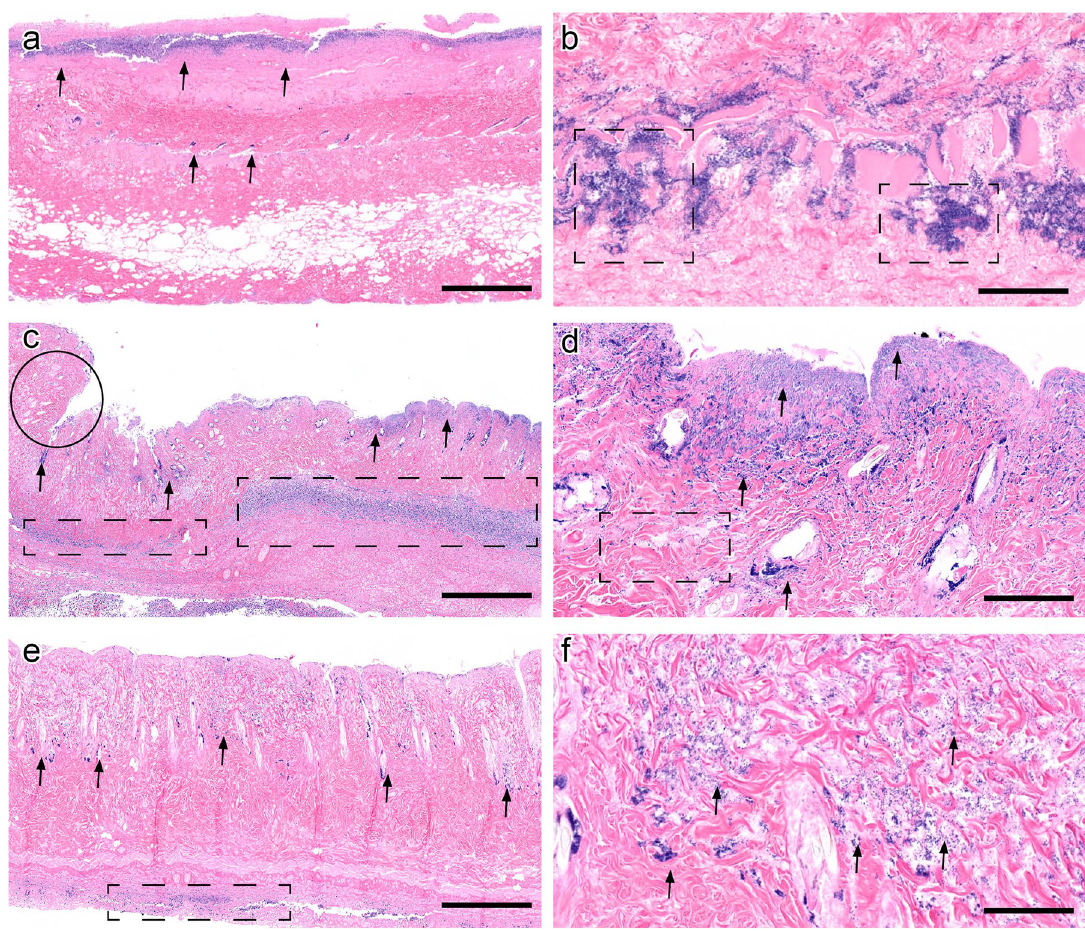
Fig 3. Histological evaluation of infected pressure ulcers in diabetic TALLYHO/JngJ mice. (a) Negative controls (vehicle alone) were characterized by dense thick carpets of superficial bacterial colonies (arrows) and full thickness necrosis, extending into the deep subcutis (image acquired at 2 × magnification). Scale bar represents 1 mm. (b) On closer view, bacteria extend deep into the dermal tissue and are innumerable, forming thick aggregates (dashed boxes, image acquired at 20 × magnification). Scale bar represents 100 μ m. (c) Mupirocin-treated diabetic animals had a diminished bacterial burden, confined to the deep dermis and subcutis (arrows) surrounded by wound contraction (circle), indicating early wound healing, absent in negative controls. Inflammation extends deep into the subcutaneous tissue (dashed boxes) in contrast to untreated controls (image acquired at 2 × magnification). Scale bar represents 1 mm. (d) On closer view, bacteria are less numerous and form small clusters compared to negative controls and collagen fibers are visible (dashed box). Scale bar represents 100 μ m. (e) Ebselen-treated animals had a pronounced decrease in bacterial burden compared to the negative control, with few scattered aggregates in the deep dermis (arrows) and normal collagen fiber architecture in between. Inflammation was sparse compared to mupirocin treatment and present only at the deep tissue margin, indicating tissue clearing and early wound healing (dashed boxes) (image acquired at 2 × magnification). Scale bar represents 1 mm. (f) Bacteria are sparse and markedly decreased compared to the negative control, with few colonies in between collagen fibers and occasionally forming clusters (arrows) (image acquired at 20 × magnification).